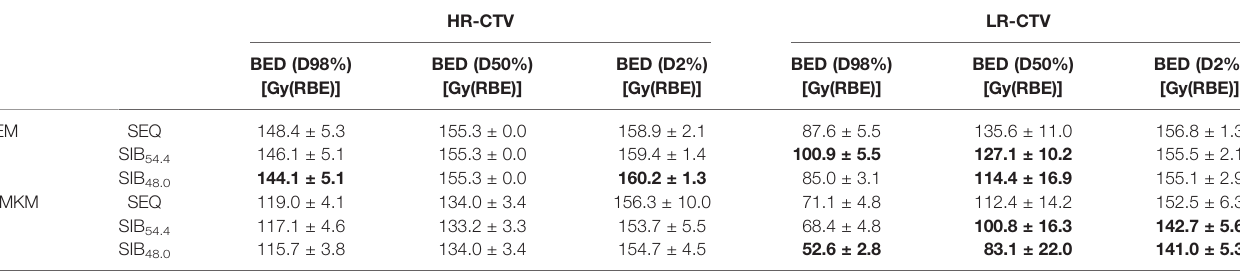
TABLE 4 | Mean values ( ± 1 standard deviation) of the biologically effective dose (BED) obtained with the three treatment approaches, reported for both radiobiological calculation models.